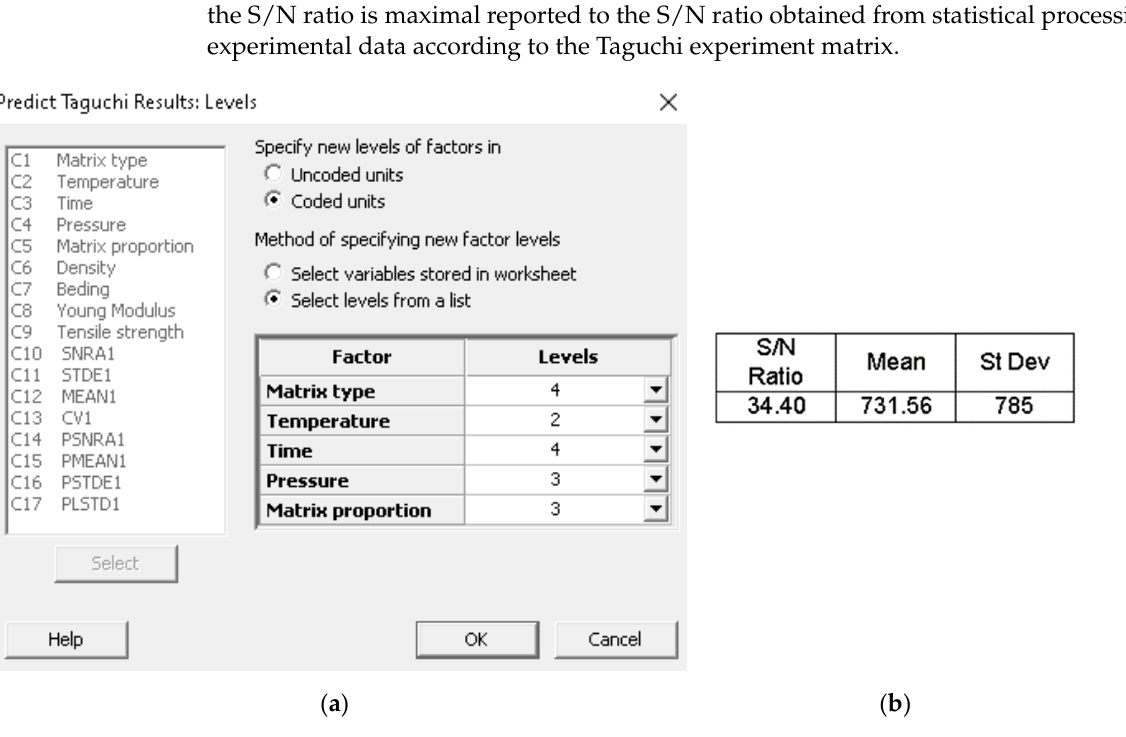
Table 7. Mechanical properties of the obtained optimum model of the waste based composite material.